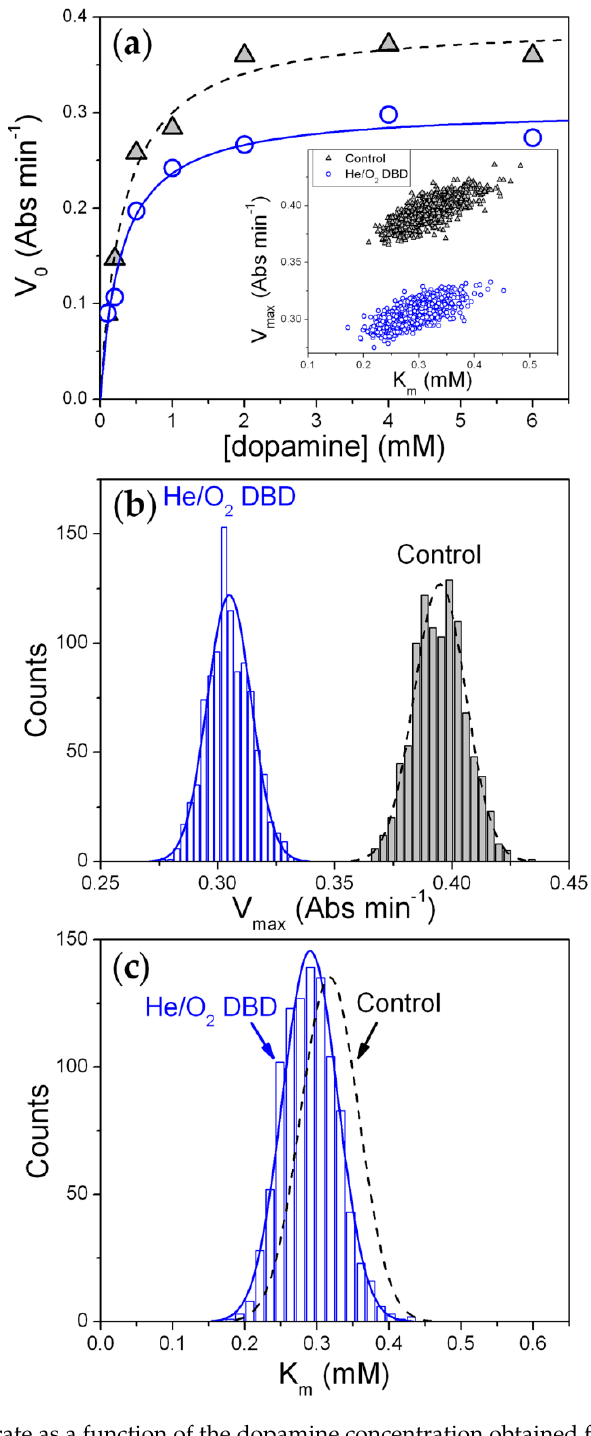
Figure 5. ( a ) Initial rate as a function of the dopamine concentration obtained for 5 µ g of tyrosinase redissolved in buffer solution after drying (i.e., control sample; grey triangle) and after drying and exposure to He / 1% O 2 DBD for 30 min (blue circle); lines correspond to the fit to Equation (1). The results from 1000 runs of Monte Carlo analysis of best-fit data in panel ( a ) are shown in the inset of panel ( a ) (correlation between the V max and K m best-fit values), in panel ( b ) (frequency of the V max ), and in panel ( c ) (frequency of the Michaelis constant, K m ).